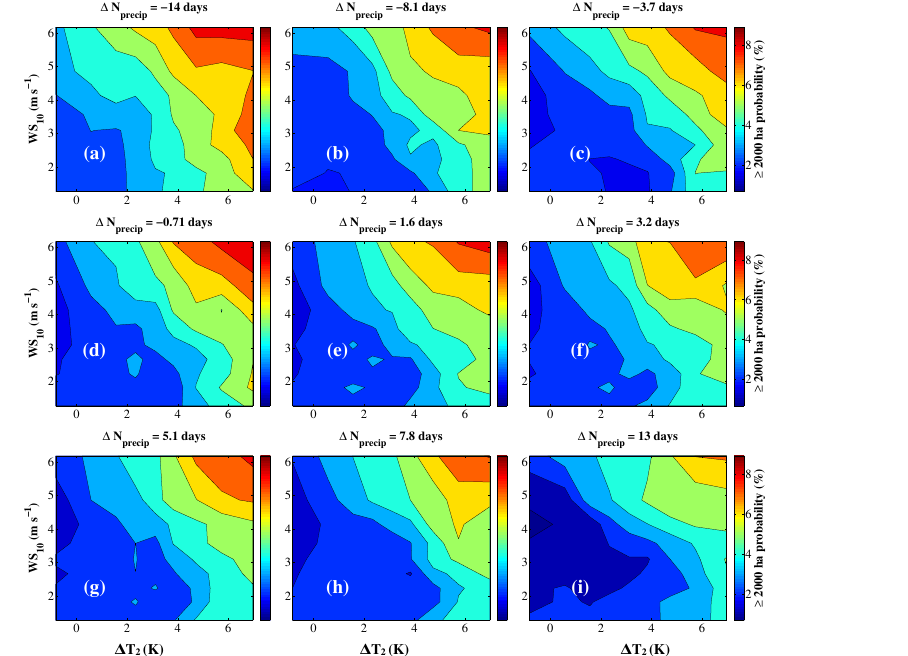
Figure 4. Estimated probabilities of fire size (BA) exceeding the 2000ha threshold (BA E data set). The x axis is the 2m air temperature anomaly ( (cid:49)T 2 ), the y axis the 10m wind speed (WS 10 ) and each panel stands for values of January–June precipitation days anomaly ( (cid:49)N precip ) centred on the given value on the panel